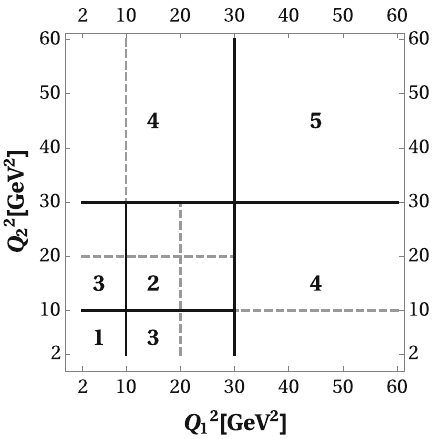
, Q 2 ) plane. Black lines and 1 2